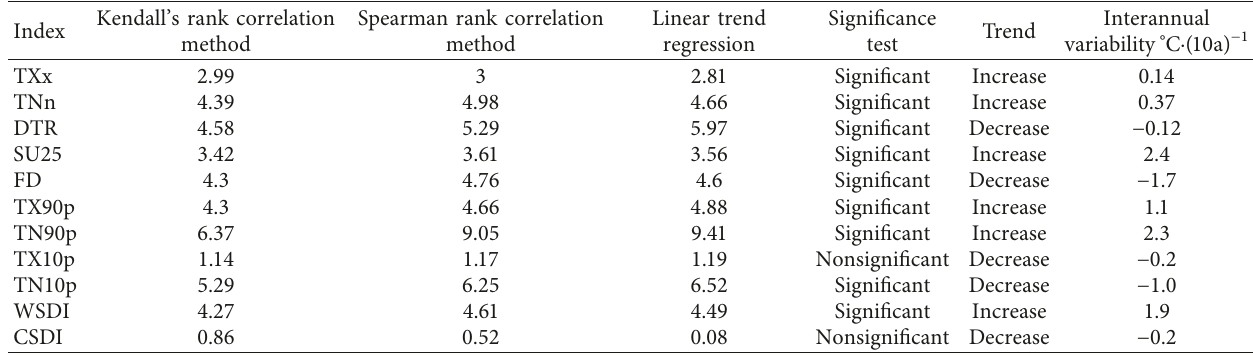
Table 3: Results of the extreme temperature trend